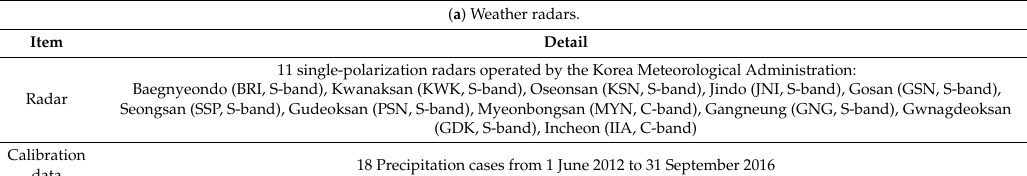
Table 1. Summary of the radars and precipitation cases in this